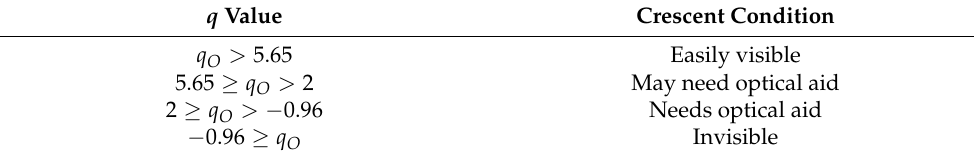
Table 4 illustrates the crescent conditions according to Odeh: Table 4. Crescent Conditions for Odeh criterion [17].